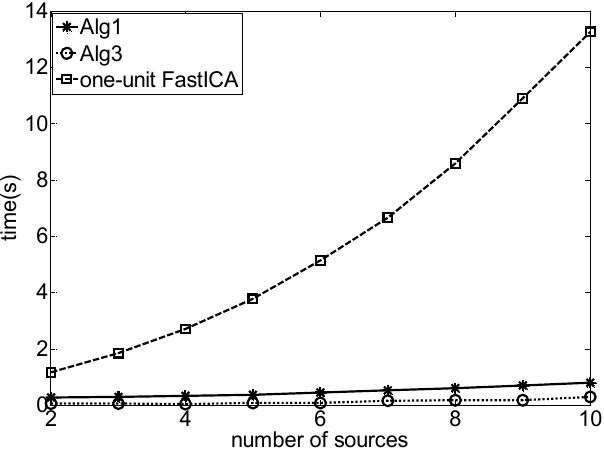
Figure 7. Comparison of the performance in the case of different number of the